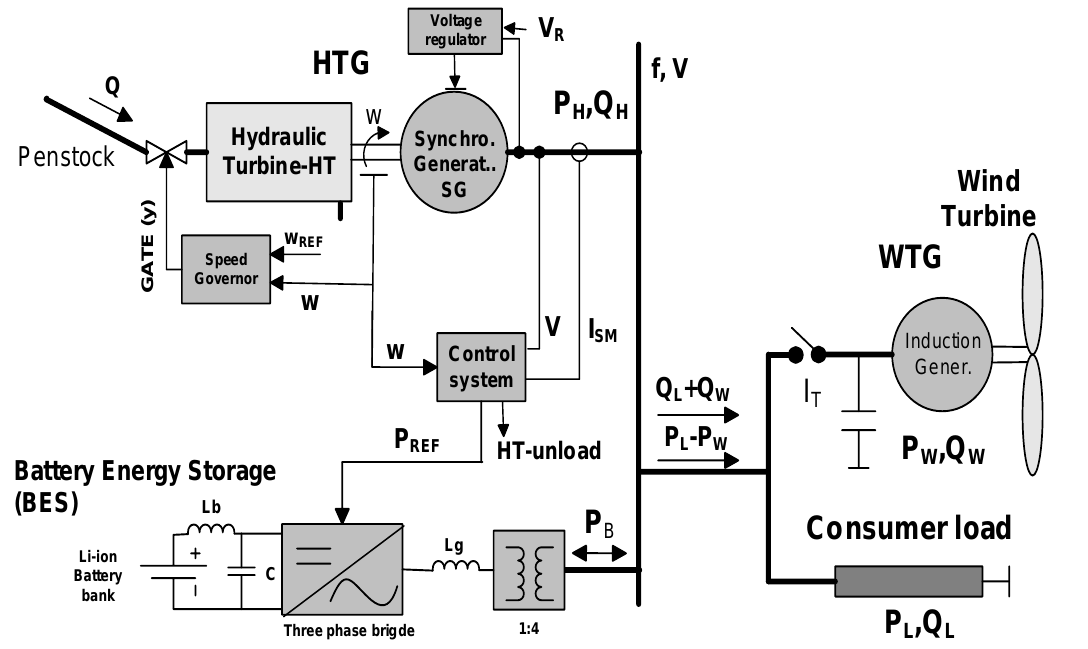
Figure 1. Wind Hydro isolated Microgrid (WH-MG) diagram.